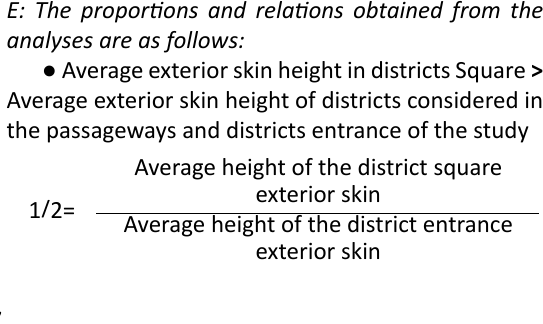
Fig. 11: Exterior skin of Waqht al‐Saat Square in Yazd